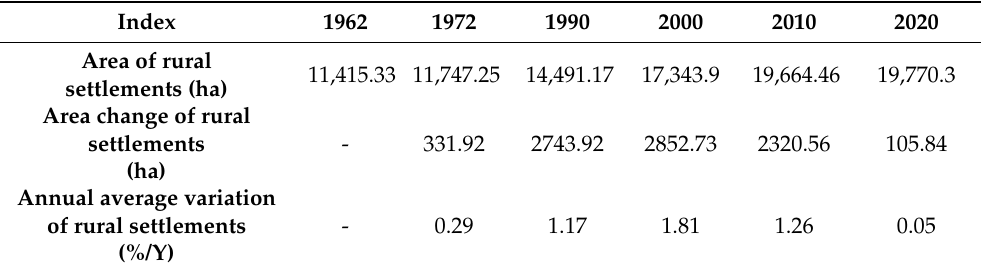
Table 1. Change index of rural settlements in Dingzhou,